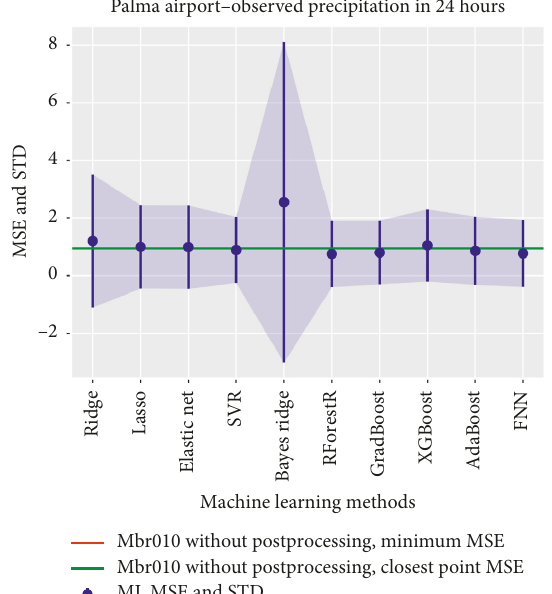
Figure 25: Precipitation in 24hours, standardized calibration plot for Palma airport. Horizontal axis as in Figure 18.